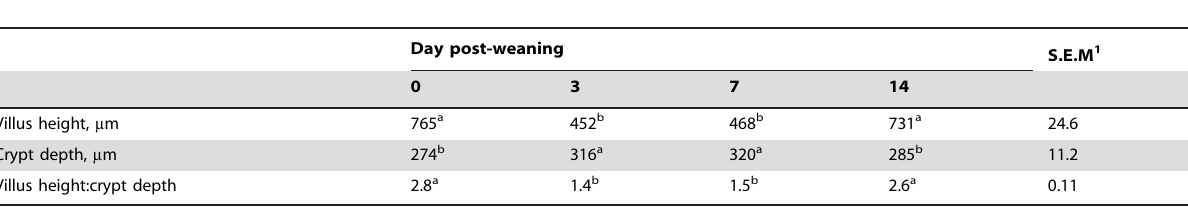
Table 2. Intestinal mucosal morphology of piglets after weaning.